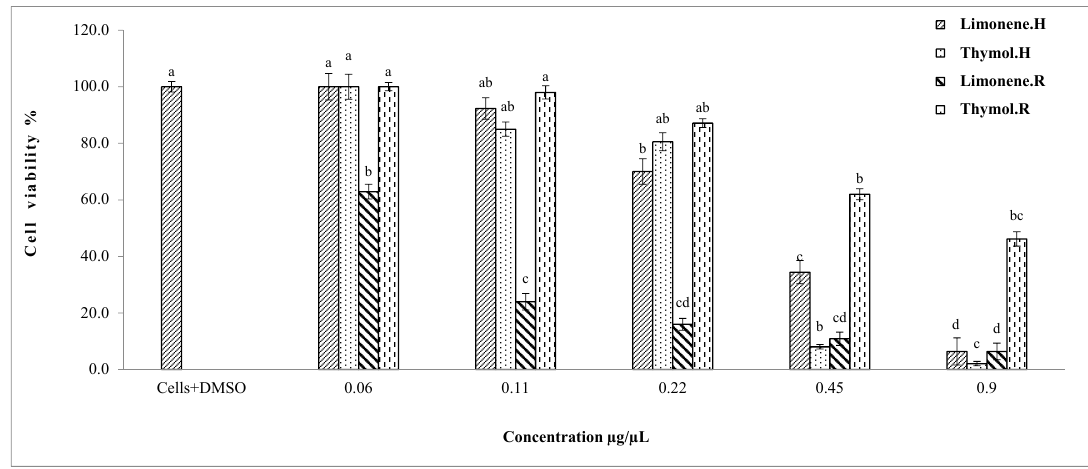
Figure 4. Viability percentage of HepG2 and HEK293 cells after treatment of thymol and limonene. Bars with different letters for each single substance indicate mean values significantly different at p < 0.05 according to Tukey (B) test. Data are expressed as mean of three replicates ± SD. Where: carvacrol.H: liver cells treated with carvacrol; citral.H: liver cells treated with citral; carvacrol.R: renal cells treated with carvacrol; citral.R: renal cells treated with citral.